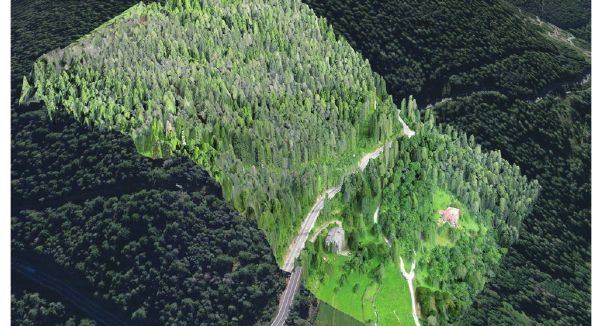
Figure 8. Real-time point cloud (19.7 Millions of